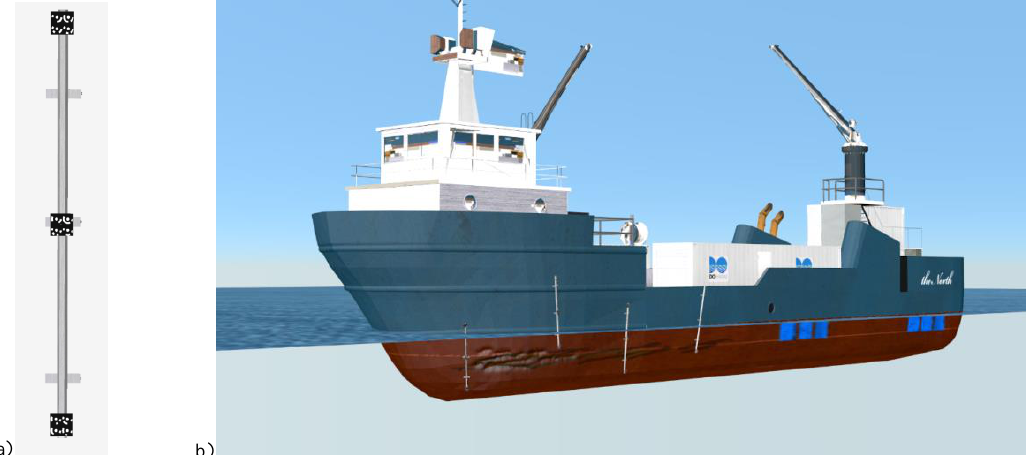
Figure 4. An example of Orientation Device (OD) with four targets attached to three plates (a). Four ODs fixed to the object and surrounding the area of interest (b).